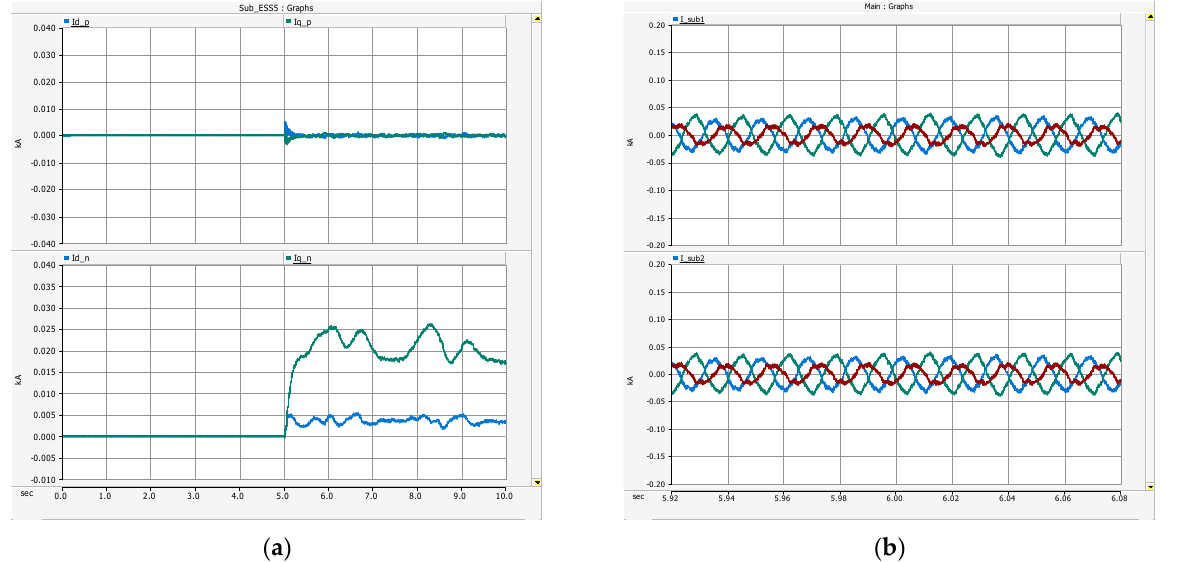
Figure 18. Simulation results of Scenario 2 ( a ) sBESS (top: dq-axis PSC; bottom: dq-axis NSC) and ( b ) sBESS (top: instantaneous three-phase current of #1 sBESS; bottom: instantaneous three-phase current of #2 sBESS).